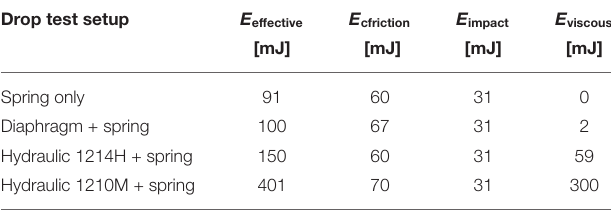
TABLE 4 | Leg drop experiments and their individual energetic losses per drop. Drop test setup